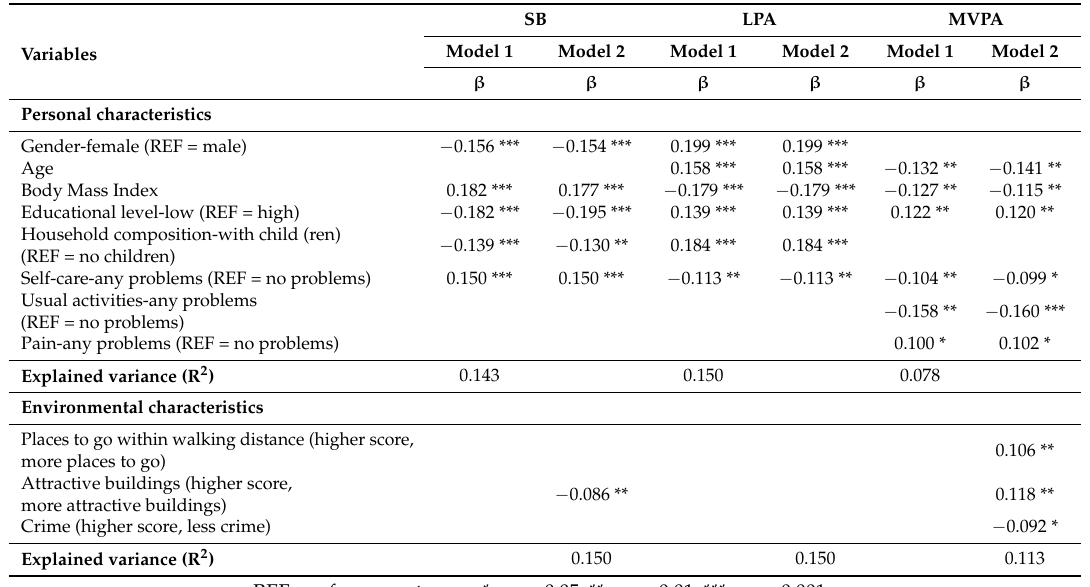
Table 4. Multivariate linear regression models for SB, LPA and